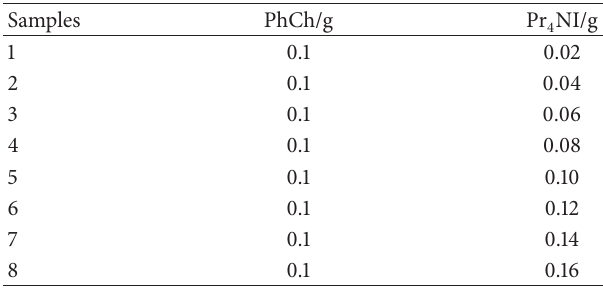
Table 1: Pr NI content of different electrolyte samples. 4